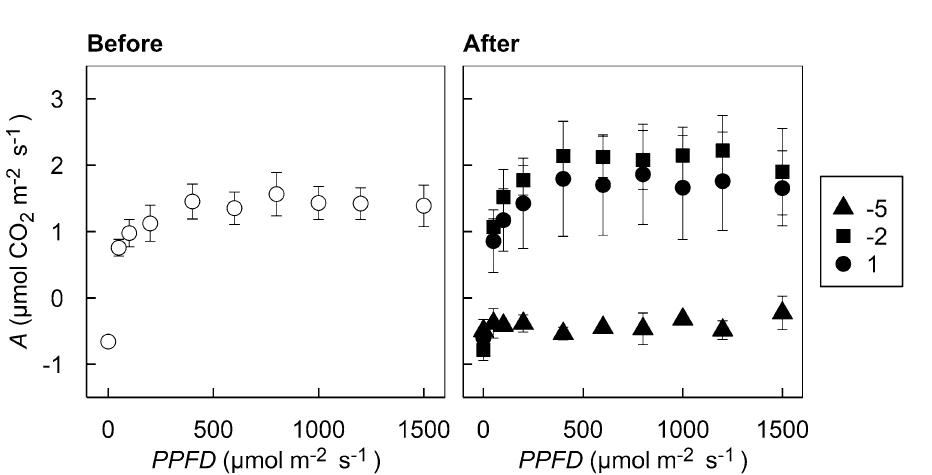
Figure 5. A - PPFD curves, net photosynthetic CO 2 assimilation rate ( A ) as a function of photosynthetic photon flux density ( PPFD ) of three-year-old ‘Haas’ avocado seedling leaves before (left) and after (right) short-term low temperature treatments. All symbols present the mean responses of biological replications ( n = 6 and 3 for before and after treatments, respectively). Error bars show the standard errors of the means for A . Closed triangles, squares, and circles after treatments indicate the responses of the samples after treated with 1 h 1, − 2, and − 5 °C,